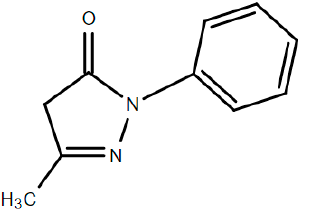
Figure 2. Chemical structure of edaravone.